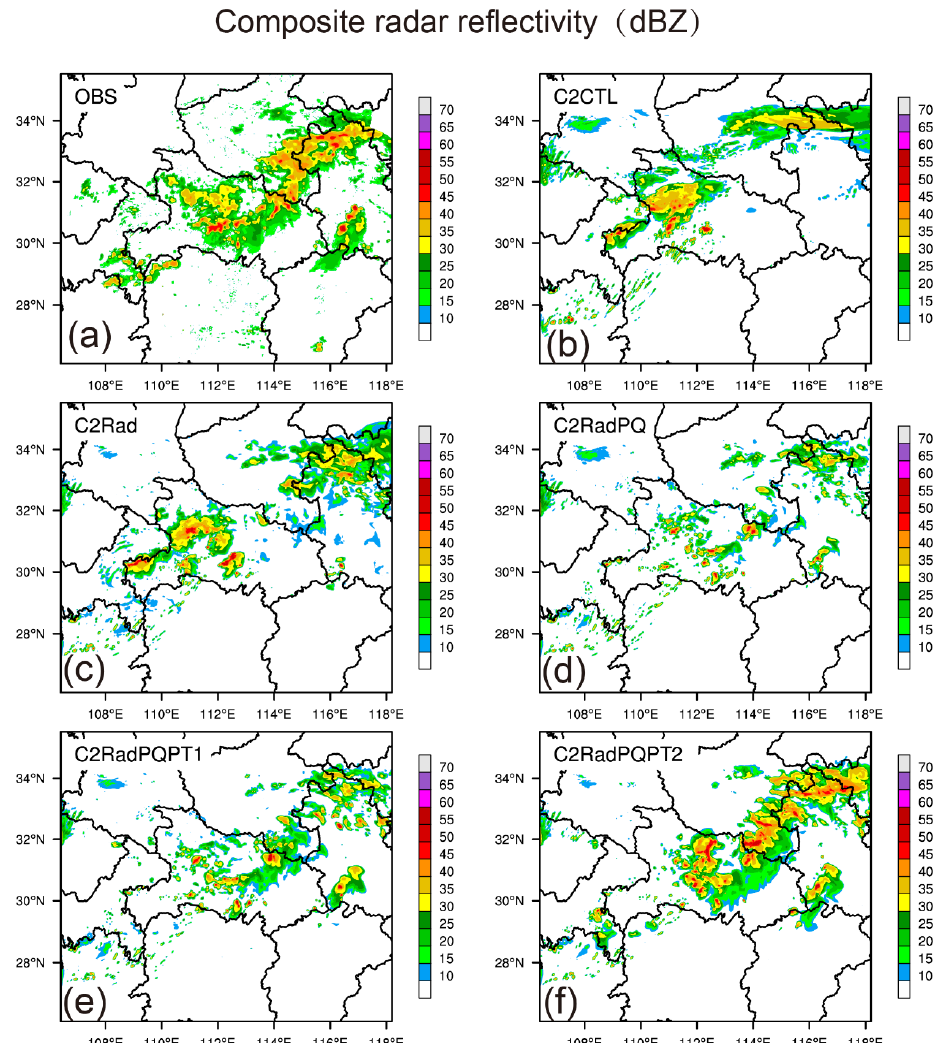
Figure 12. Same as in Figure 6, but for 1-h forecasted composite radar reflectivity (dBZ) launched at 1400 UTC (4 July, 2018).